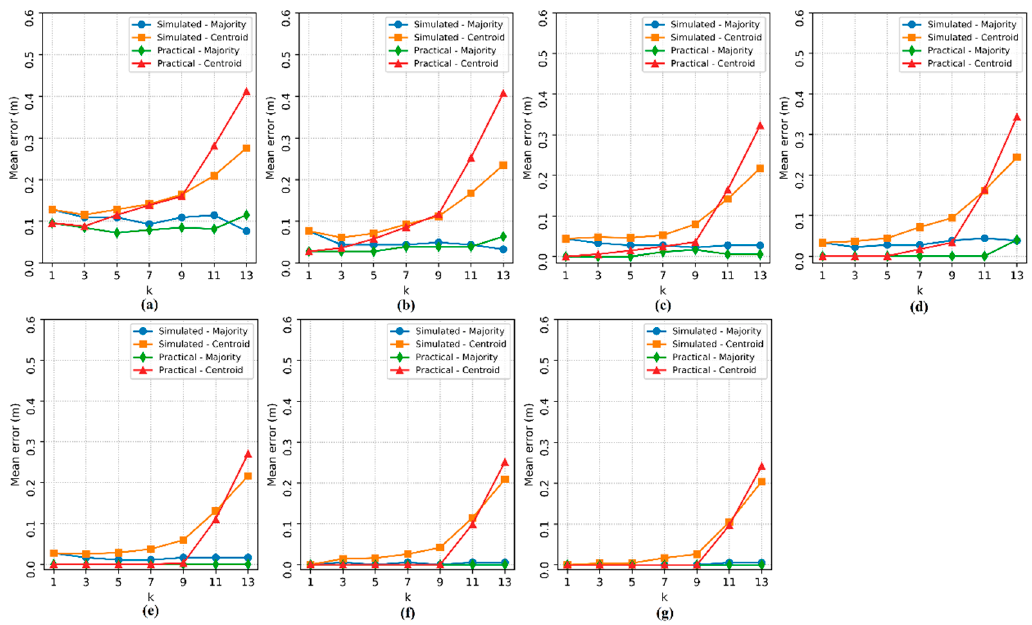
Figure 10. Localization mean error in the simulated environment and in the real environment. The subfigures show the tests for each number of access points: ( a ) 2 APs, ( b ) 3 APs, ( c ) 4 APs, ( d ) 5 APs, ( e ) 6 APs, ( f ) 7 APs and ( g ) 8 APs.